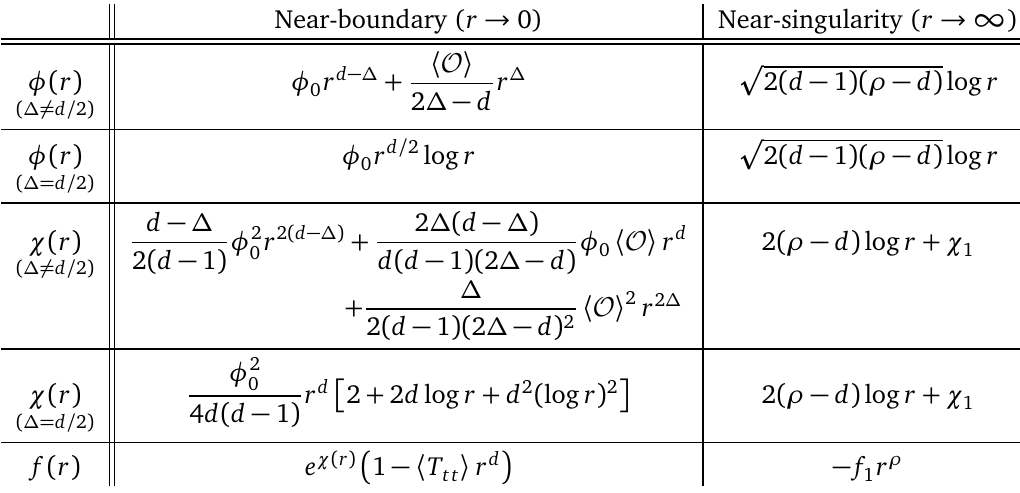
Table 1: The near-boundary and near-singularity expressions for the radial func- tions characterizing a Kasner flow ansatz for the Einstein + scalar theory. The near- boundary data is controlled by the deformation parameter φ near-singularity data is determined by the Kasner exponent p